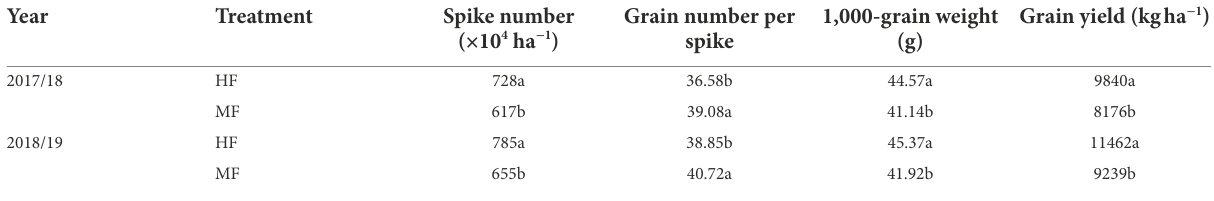
TABLE 4 Yield components and grain yield under different treatments in 2017/18 and 2018/19 growing